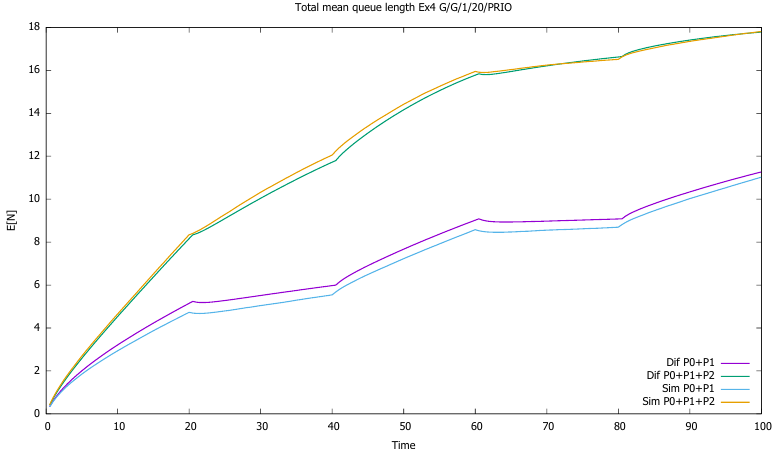
Figure 14. Section 3.4, three priorities: total mean queue length as a function of time of three priority